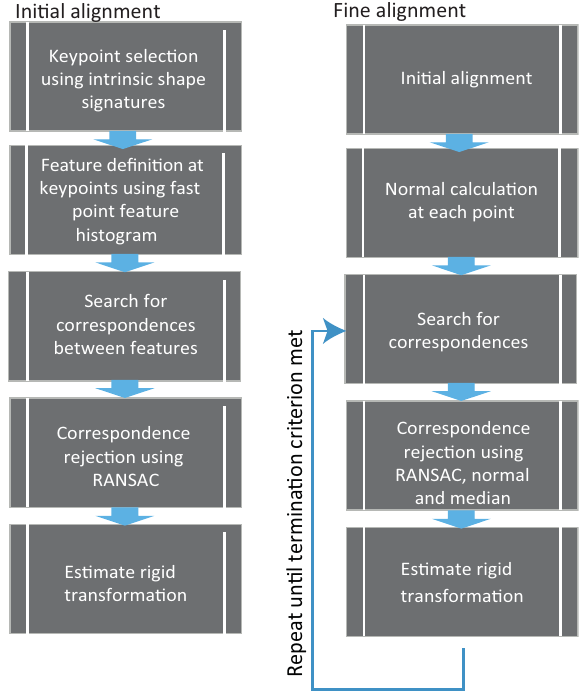
Figure 5. Registration pipeline workflow consisting of an initial alignment stage and a fine alignment stage. The initial alignment stage aligns two point clouds independent of orientation and po- sition and is based on keypoint and descriptor matching. The fine alignment stage is an iterative corresponding point variant consist- ing of a matching, rejection and alignment